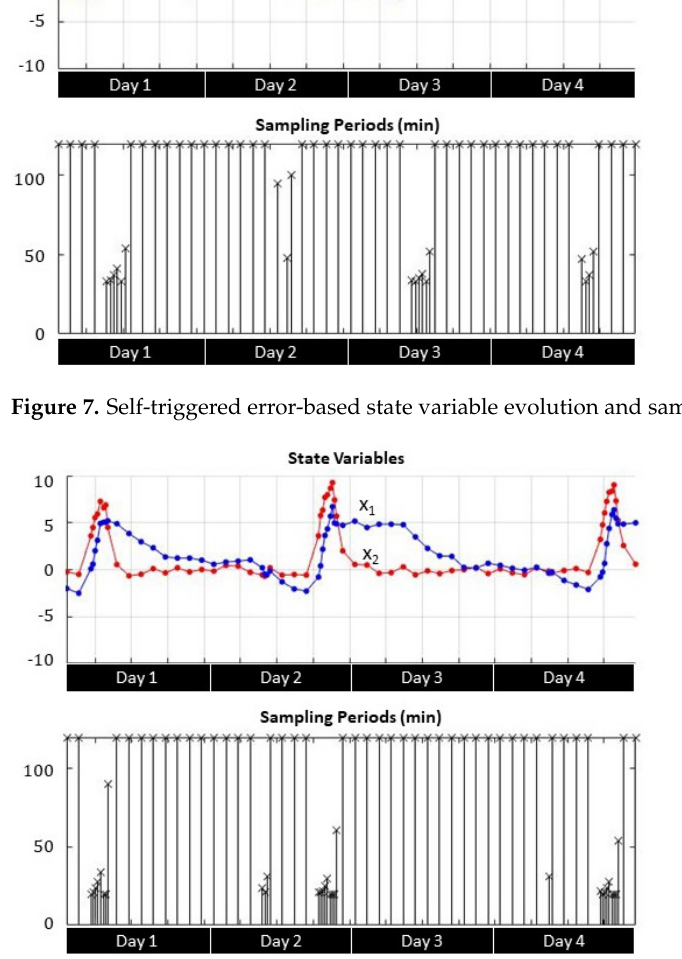
Figure 8. Self-triggered Lyapunov-based state variable evolution and sampling